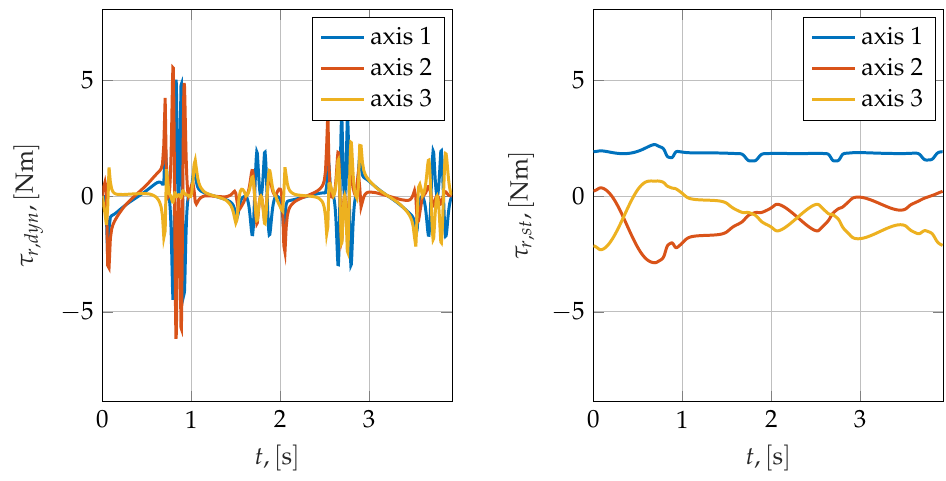
Figure 12. Dynamic and static torques at the actuated pulleys, payload 2.